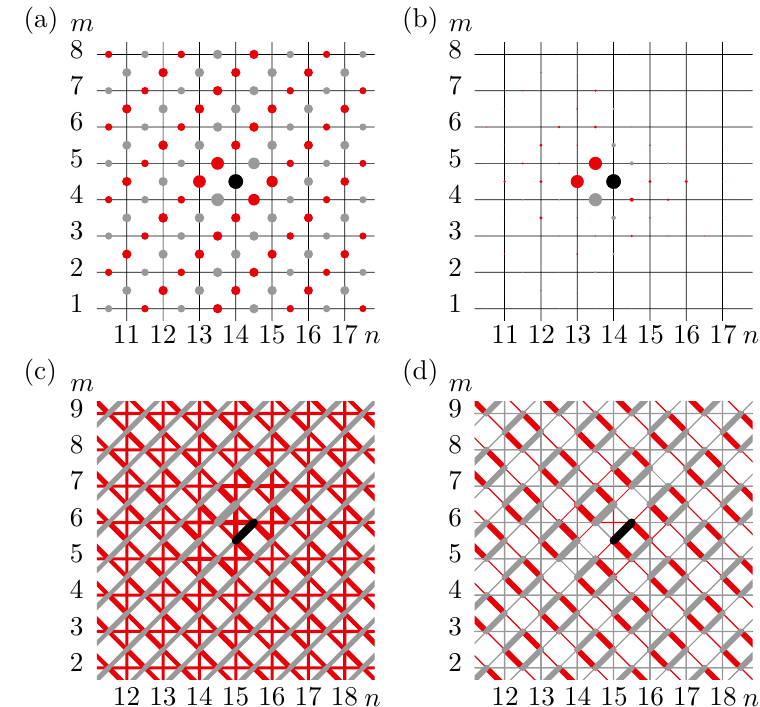
σ z 〉 that enter O in Eq. (8), Néel r s Eq. (9). Red RVBS